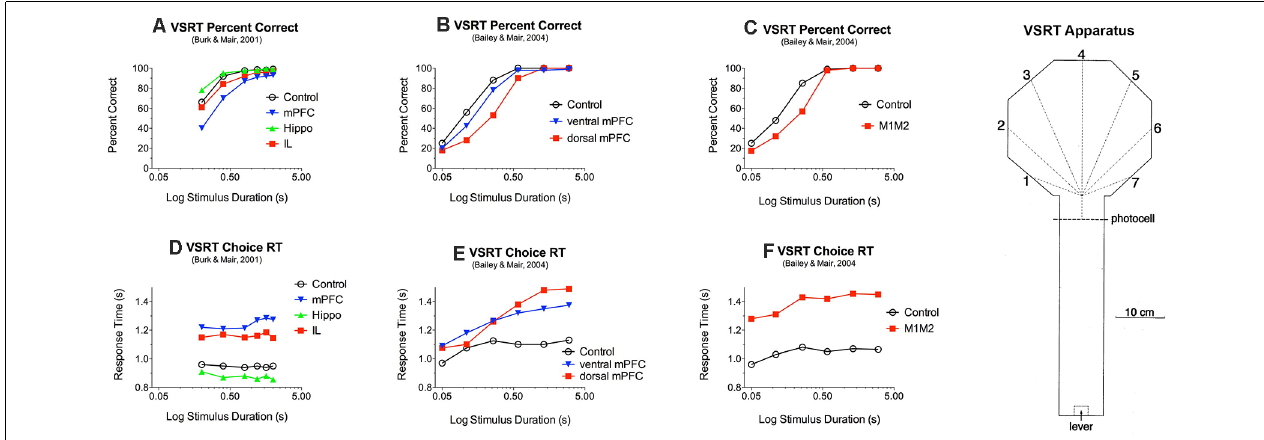
FIGURE 3 | Effects of medial prefrontal (mPFC) and motor (M1M2) cortex and rostral intralaminar (IL) thalamic lesions on reaction time (RT) and accuracy of responding to luminance cues in the visuospatial reaction time (VSRT) task. VSRT trials were initiated by a lever press at the end of the arm. A brief luminance cue was then triggered to indicate the S+ response port when the rat crossed the photocell just before entering the octagonal hub. Water reinforcement was delivered in the S+ port if the rat entered it first within a 3.0 s limited hold. PFC and M1M2 lesions had duration-dependent effects on response accuracy (A,B,C) and increased RT for (D,E,F) . IL thalamic lesions increased RT (D) but did not have a significant effect on choice accuracy (A) . Data are replotted from studies